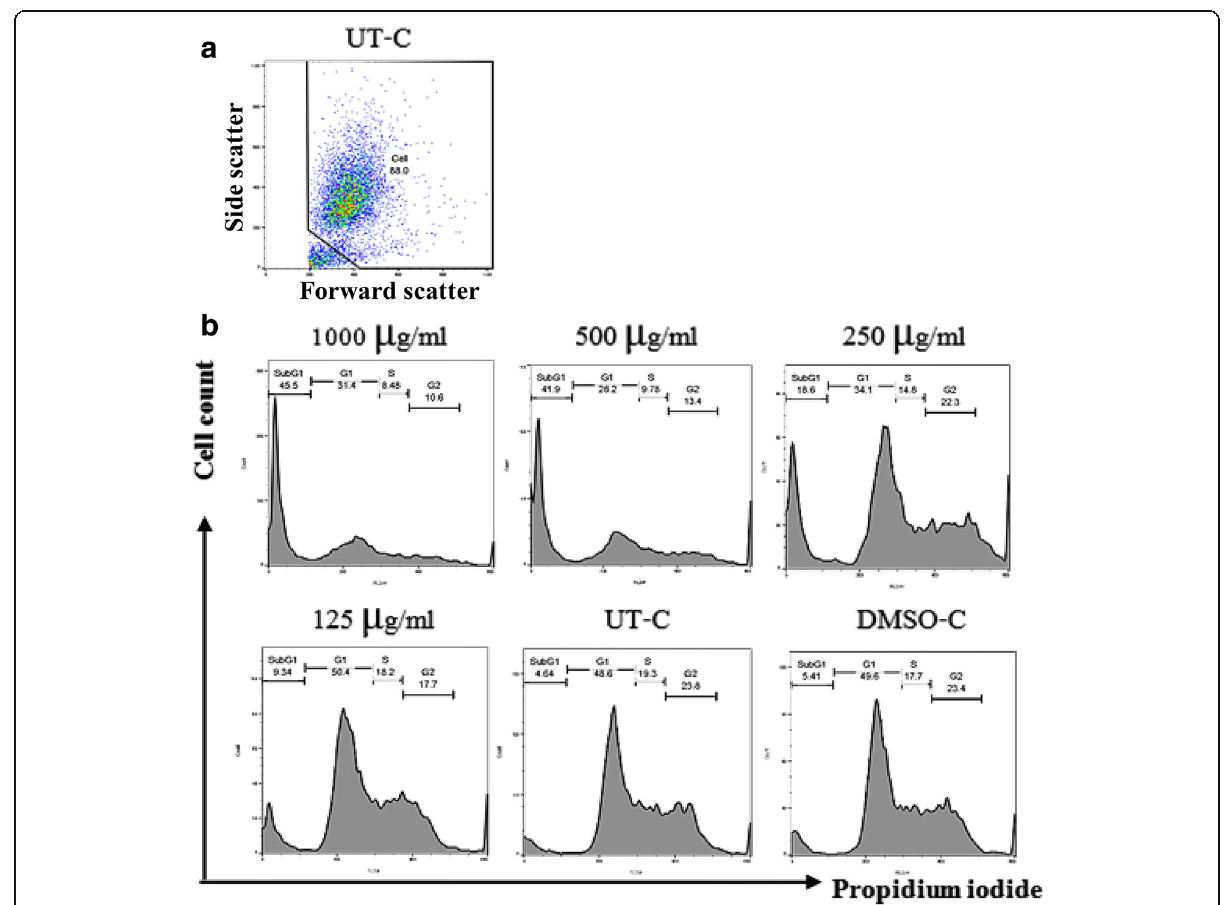
Fig. 2 Cell cycle analysis of RAJI cells treated with 125 – 1000 μ g/ml of crude extract from the leaves of M. modestum (LMM). Untreated (UT-C) cells and DMSO were used as the controls. a shows the gating strategy and b histograms show the patterns of cells stained with PI